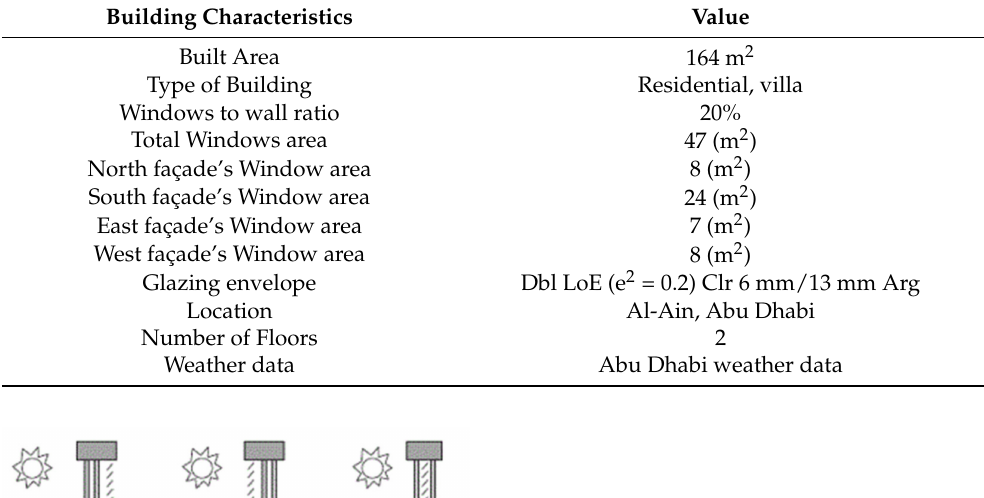
Figure 1. The 3D external model of UAE residential villa. Table 2. Base case building descriptions.